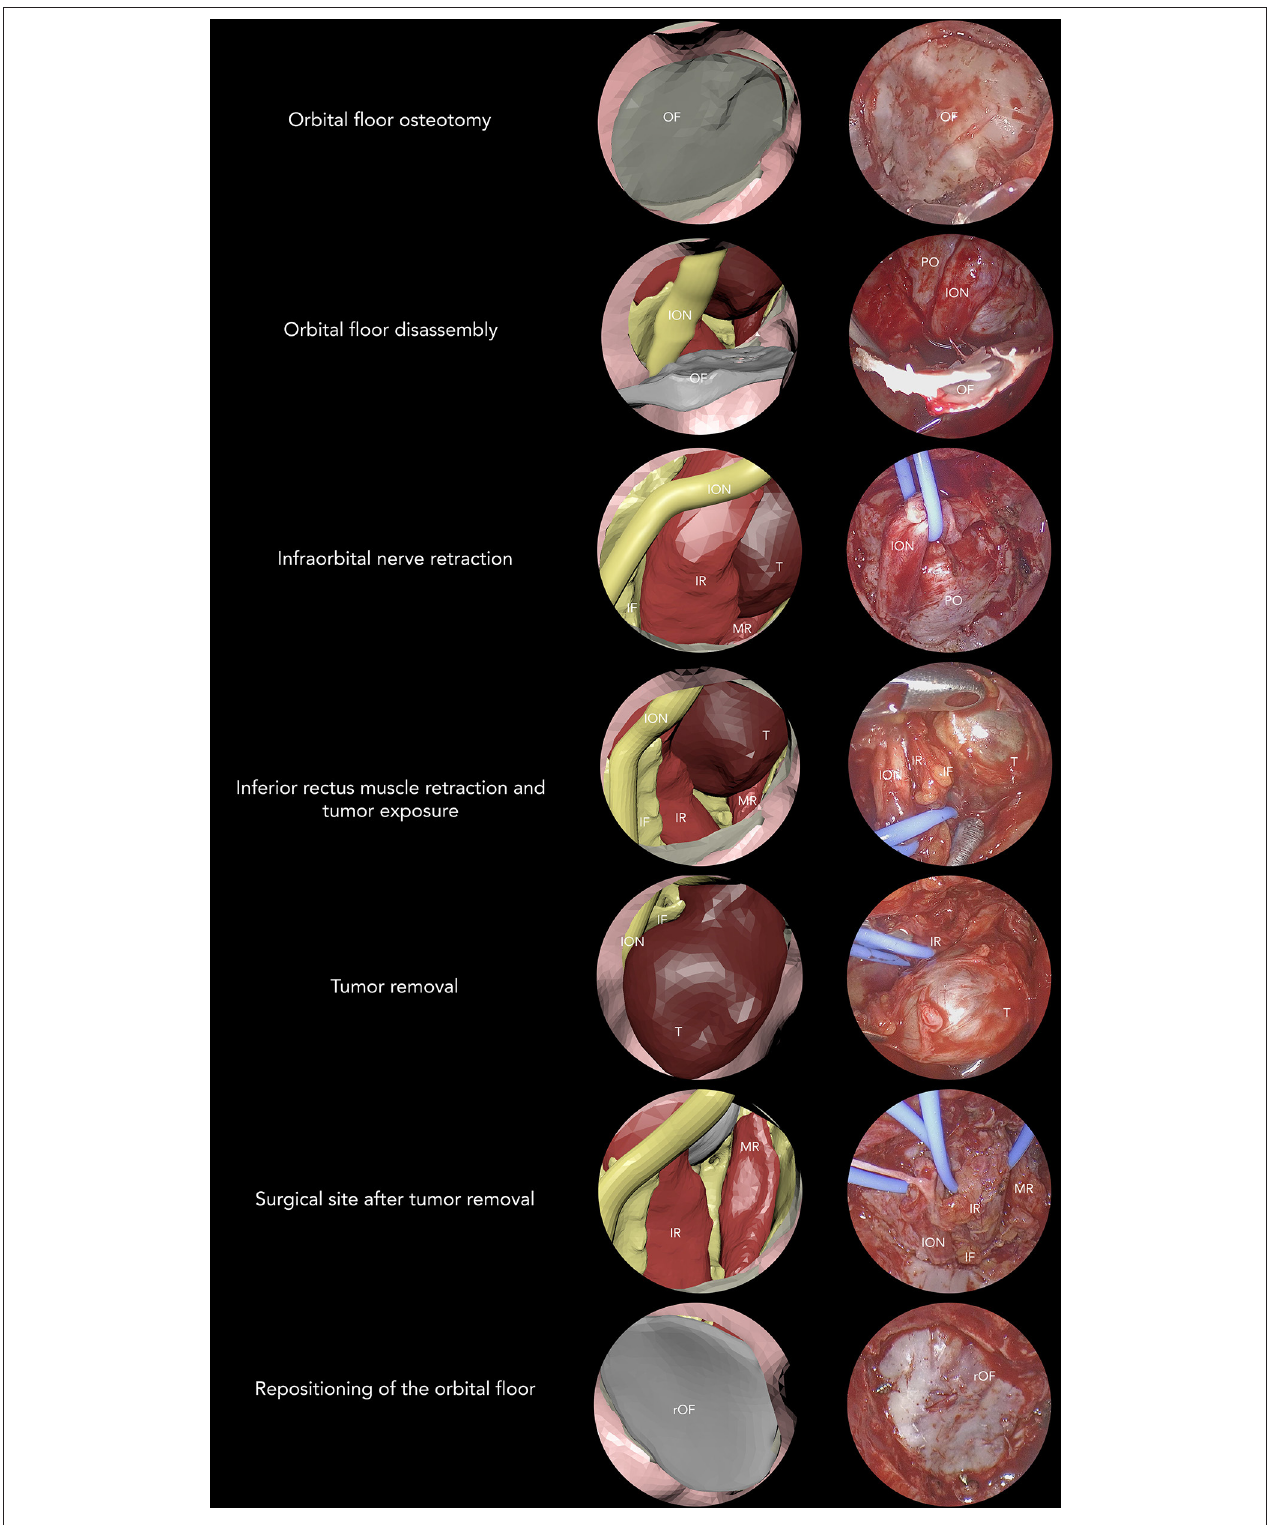
FIGURE 8 | Seven-phase procedure is shown by associating virtual and real endoscopic images. OF, orbital floor; ION, infraorbital nerve; PO, periorbita; IR, inferior rectus; MR, medial rectus; T, tumor; IF, intraconal fat; rOF, reconstructed orbital floor.